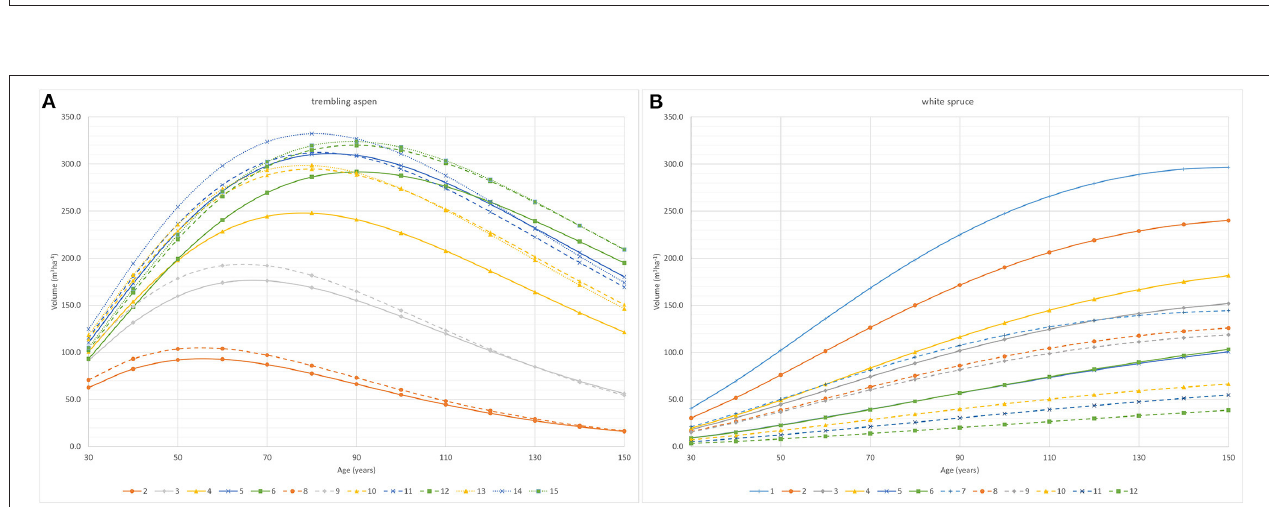
FIGURE 8 | Treatment level volume-age curves for (A) aspen and (B) white spruce based on MGM forecasts of aspen gross stand volumes for each treatment. [Treatments (trees ha − 1 at age 5): Plot 1 = 1000Sw/0Aw; plot 2 = 1000Sw/200Aw; plot 3 = 1000Sw/500Aw; plot 4 = 1000Sw/1500Aw; plot 5 = 1000Sw/4000Aw; plot 6 = 1000Sw/unthinned Aw; plot 7 = 500Sw/0Aw; plot8 = 500Sw/200Aw; plot 9 = 500Sw/500Aw; plot 10 = 500Sw/1500Aw; plot 11 = 500Sw/4000Aw; plot 12 = 500Sw/unthinned Aw; plot 13 = 0Sw/1500Aw; plot 14 = 0Sw/4000Aw; plot 15 = 0Aw/unthinned Aw].